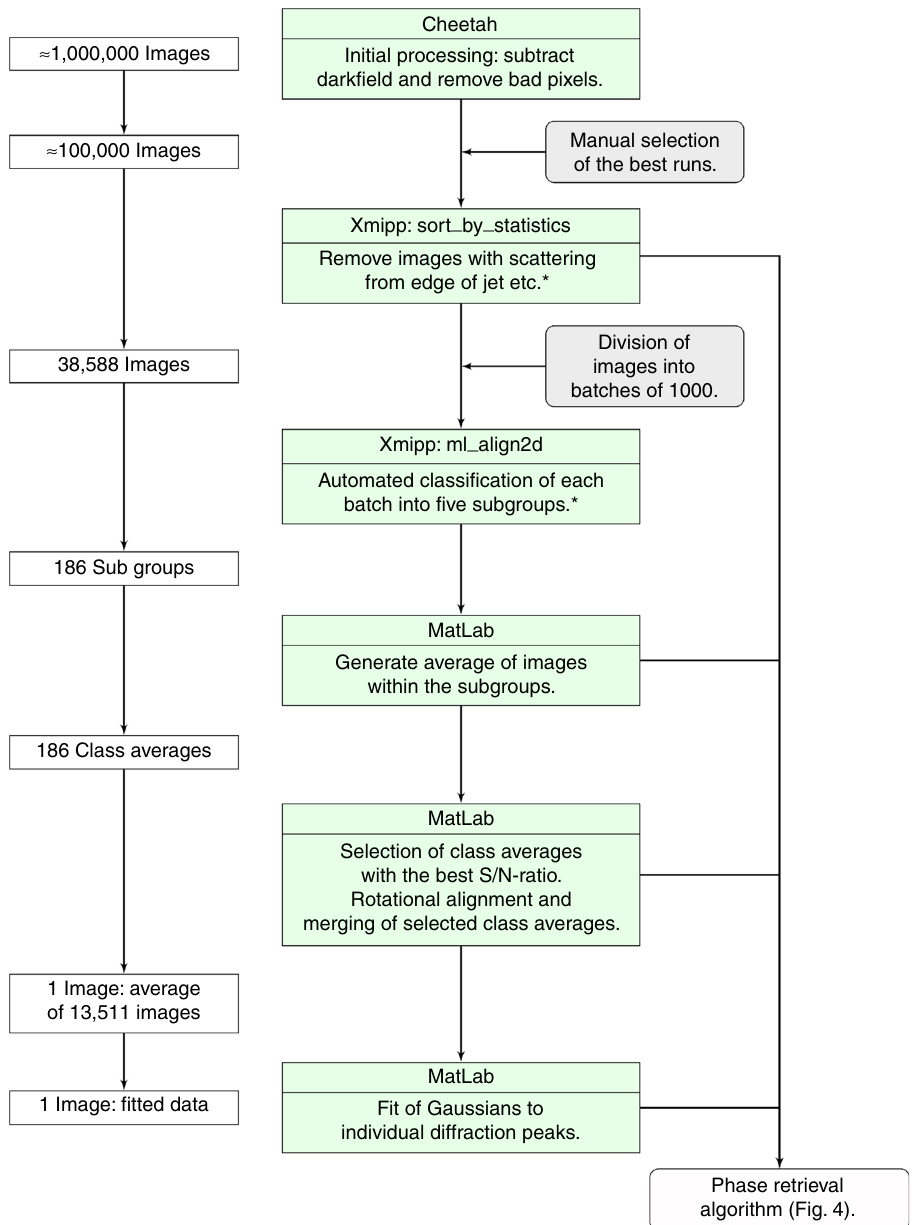
Fig. 3 Flow chart for data processing of the diffraction images. Manual intervention is indicated in gray boxes. An asterisk indicates where data processing steps used only the four central detector